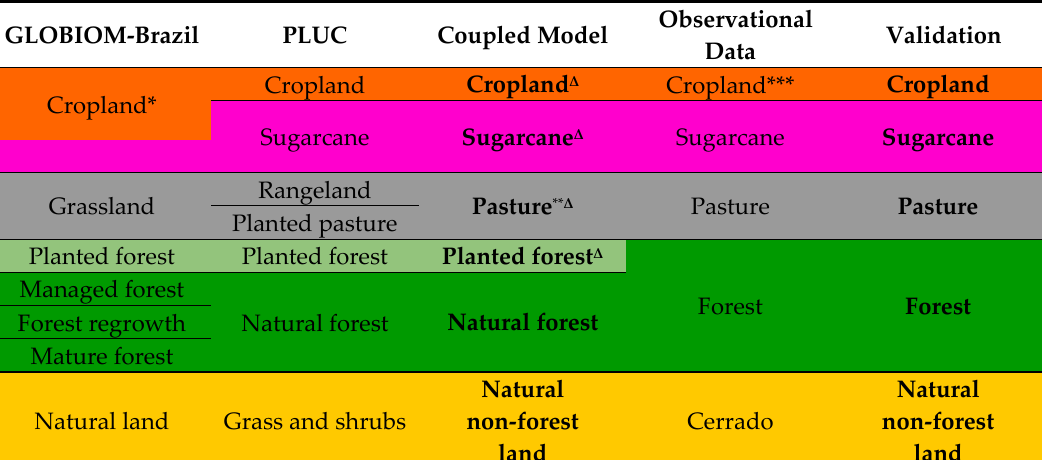
Table 1. Harmonization for model coupling between land ‐ use classes in GLOBIOM ‐ Brazil and PLUC. For the final coupled ‐ model classes, it is indicated whether or not they are used as demand ‐ driven land ‐ use (LU) classes in PLUC.